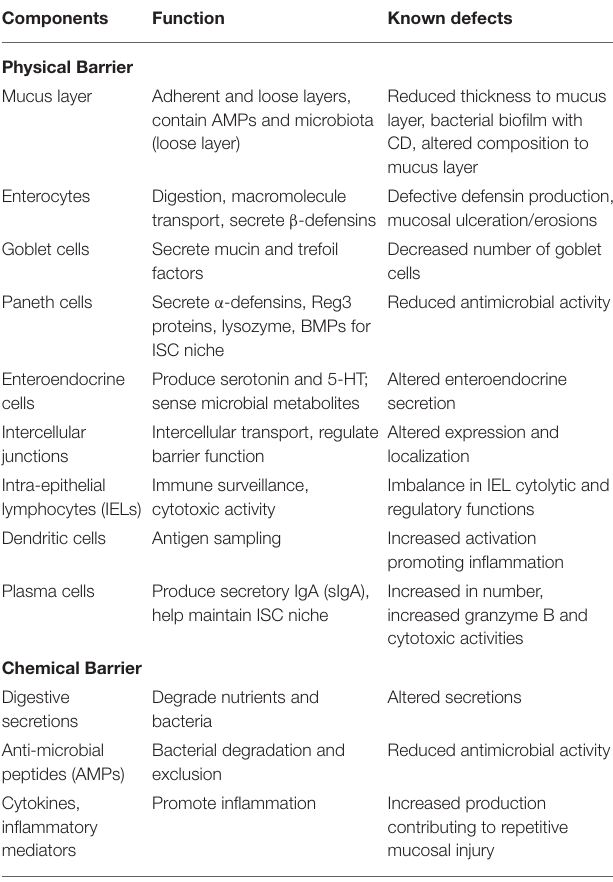
TABLE 1 | Components of the intestinal epithelial barrier and their perturbation in